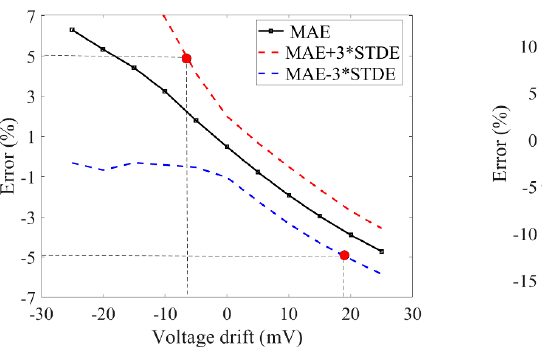
( b ) SOC estimation error with current drift. Figure 12. SOC estimation error with voltage and current drifts. Figure 12. SOC estimation error with voltage and current drifts.